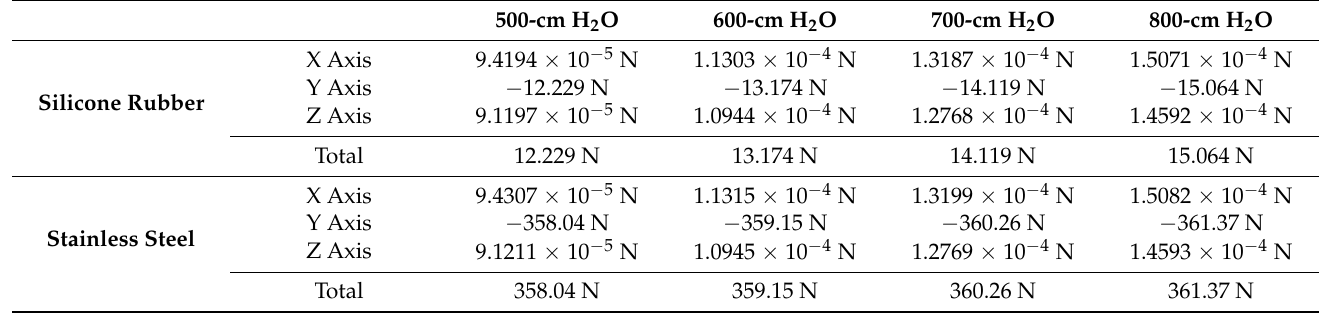
Figure 5. Direction of reaction force on the fetal head. Table 2. Magnitudes and components of reaction force.